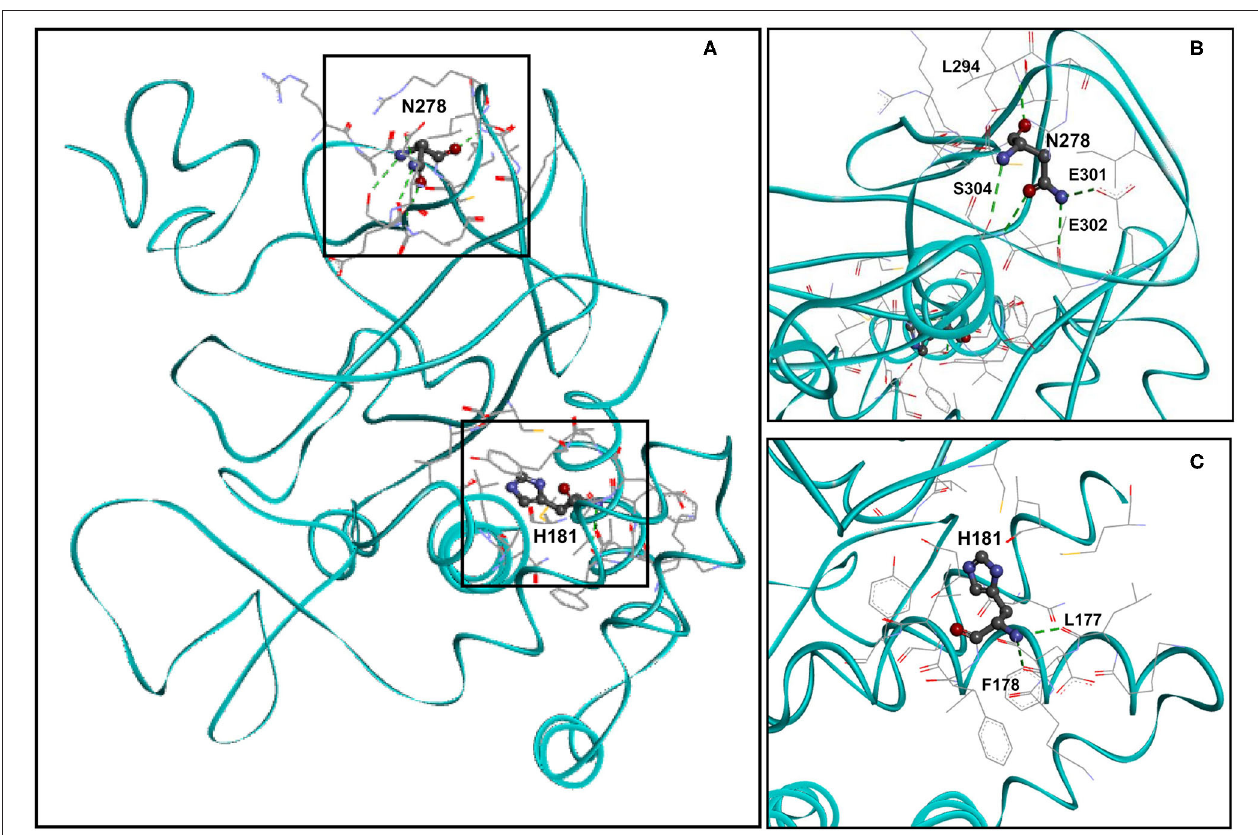
FIGURE 2 | Molecular model of wild-type KMT5B (A) . KMT5B is in cyan. Residues H181 and N278 are shown ball and stick by charge. Residues that are within 5Å distance from H181 or from N278 are shown in stick. Hydrogen bonds are presented in dashed green. (B) Close-up of wild-type residue N278 with residues that are within 5Å distance and the residues with which hydrogen bonds are formed. Five hydrogen bonds, presented in dashed green, are formed between N279 and residues L294, E301, E302 and S304. Two hydrogen bonds are formed between N278 and S304. The set of residues (by element, stick) that are within 5Å from N278 are also shown, including: R276, P277, C279, K280, K292, A293, L294, R295, I297, E301, E302, and S304. (C) Close-up of wild-type residue H181 with residues that are within 5Å distance and the residues with which hydrogen bonds are formed. Two hydrogen bonds, presented in dashed green, are formed between H181 and residues L177 and F178. The set of residues (by element, stick) that are within 5Å from H181 are also shown, including: K176, L177, F178, K179, E180, V182, F183, I184, Y185, C230, L265, and